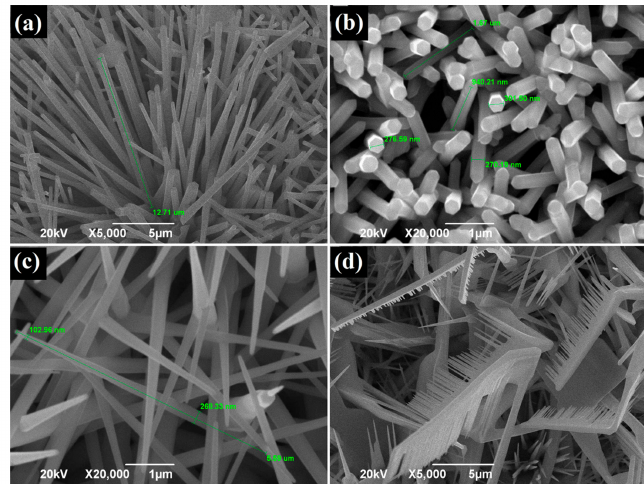
Figure 2. Scanning electron microscopy (SEM) images of ZnO nanomaterials grown on silicon